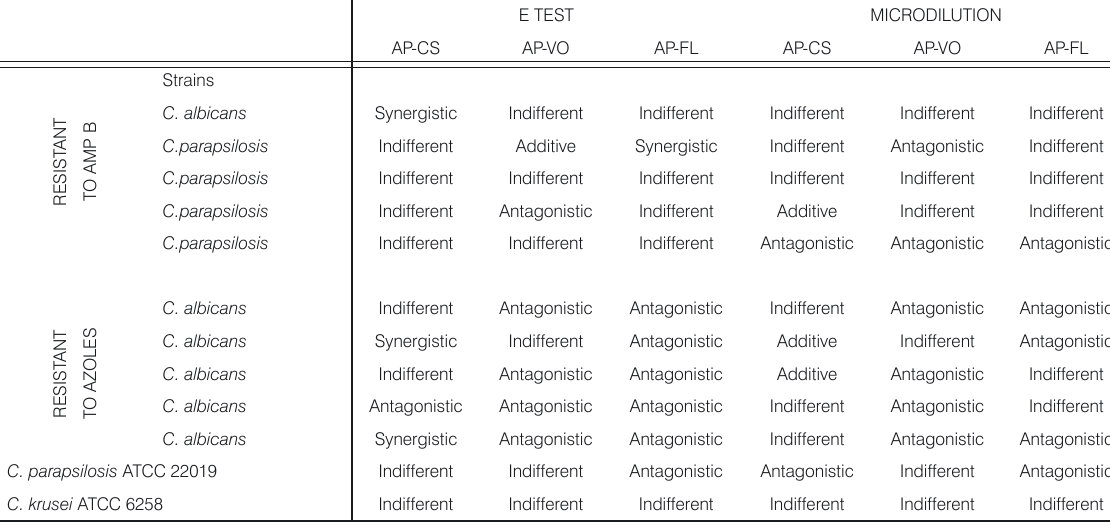
Table 1. E-test and microdilution results of synergistic